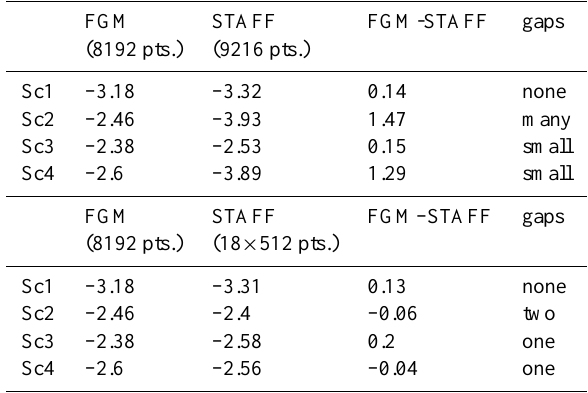
Table 1. Slopes of power spectra between [0.5–2Hz] at 5:41:00